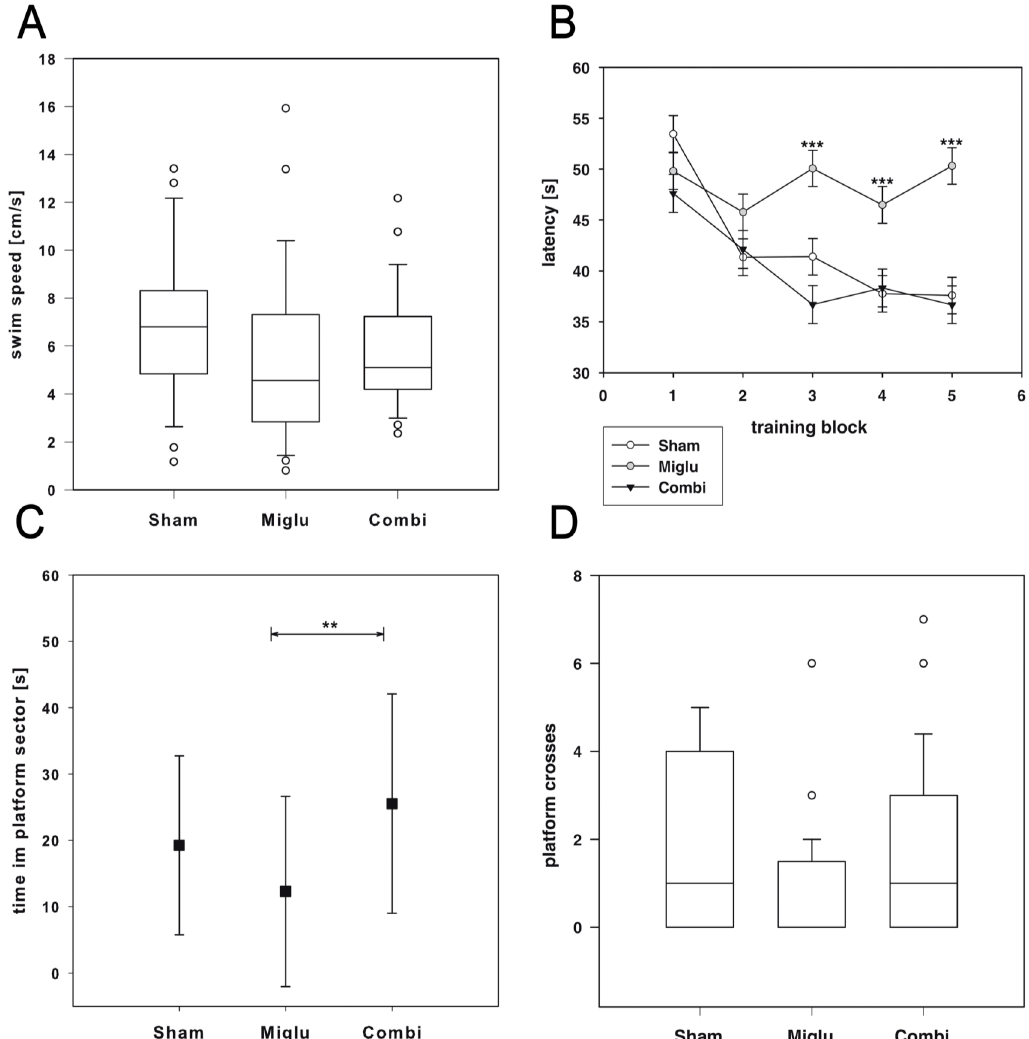
Figure 3. Water maze test. ( A ) All treatment groups ( n sham = 29, n miglu = 26, n combi = 26) showed similar swim performance ( p = 0.147); ( B ) escape latencies for the individual trials were averaged by training block. Only the miglu-group shows no improvement of spatial cognitive capabilities. During training blocks 3–5 the miglu-group showed significant worse platform finding latencies than the sham- and combi-groups; ( C ) after platform removal the miglu-treated mice spent significantly less time in the respective sector than combination-treated mice; ( D ) differences in platform crosses did not reach significance. Asterisks indicate significant differences between treatment groups after two-way analysis of variance and Holm–Sidak post hoc analysis (** p < 0.01, *** p < 0.001). Scatter plot and line chart data are represented as mean ± SEM ( B ) or mean ± SD ( A , C , D ) Box plots depict the animal groups graphically by displaying the following descriptive statistical parameters: the median, the upper and lower quartiles, and outliers (circles) that lie outside the 10th and 90th percentiles (whiskers).